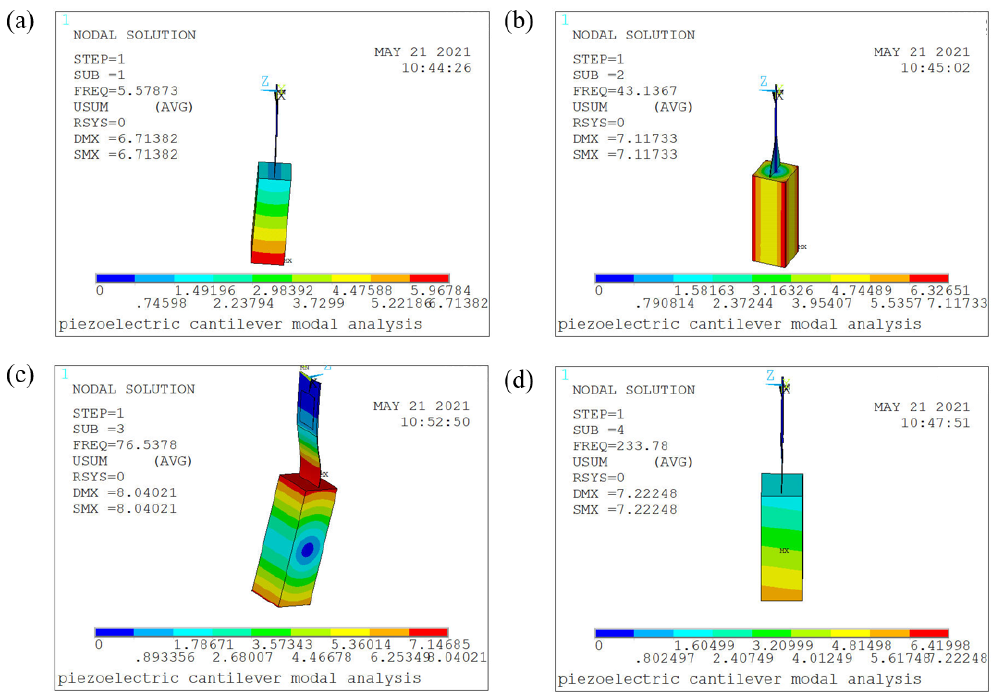
Figure 4. Stress cloud diagram of GPEEH modal analysis. ( a ) First mode ( b ) Second mode ( c ) Third mode ( d ) Fourth mode.